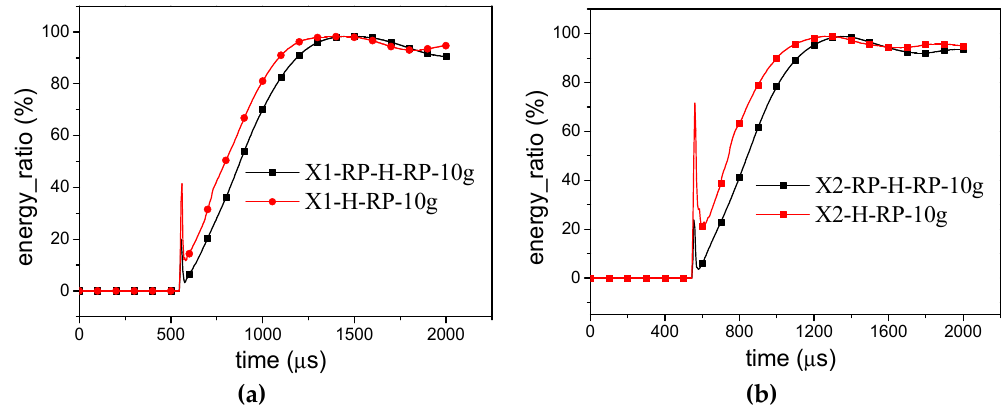
Figure 13. Comparison of energy distribution between RP-H-RP-10g and H-RP-10g (a) in the X1 direction and (b) in the X2 direction.